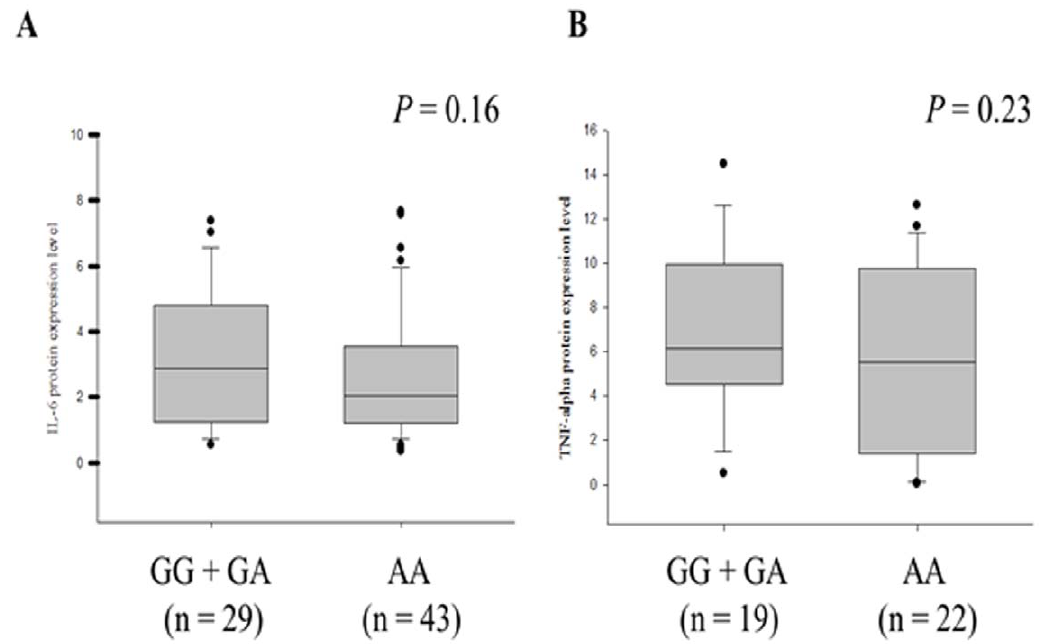
Figure 3. Comparison of serum (A) IL-6 and (B) TNF- a levels among different genotypes of STIM1 (rs3750996) in AS patients.